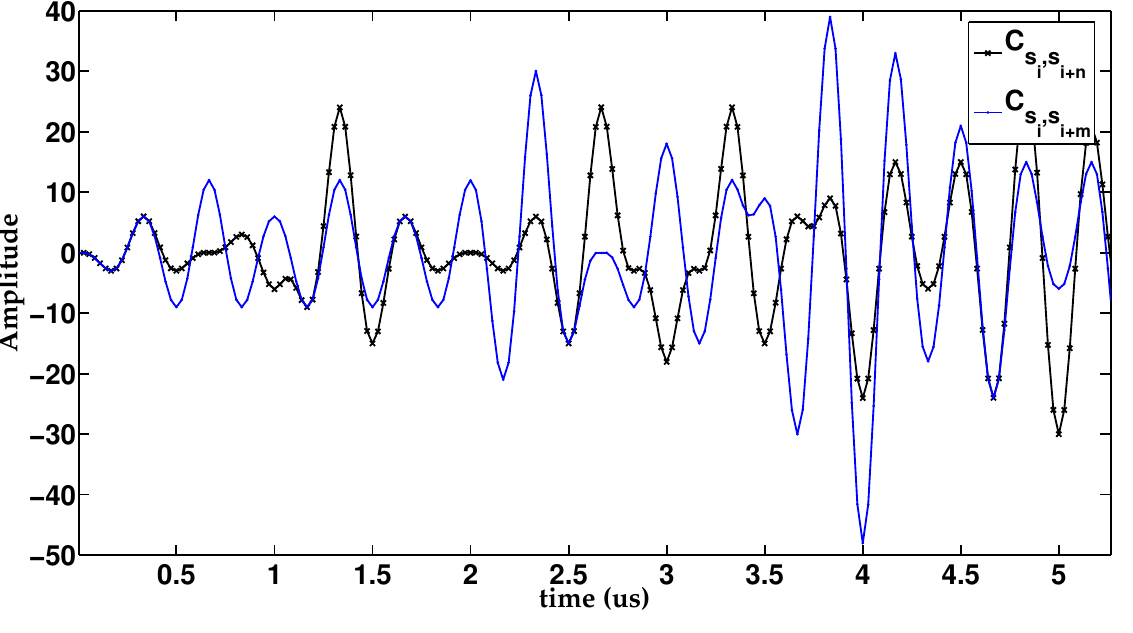
Figure 6. Cross-correlation (CC) function between two pairs of Kasami